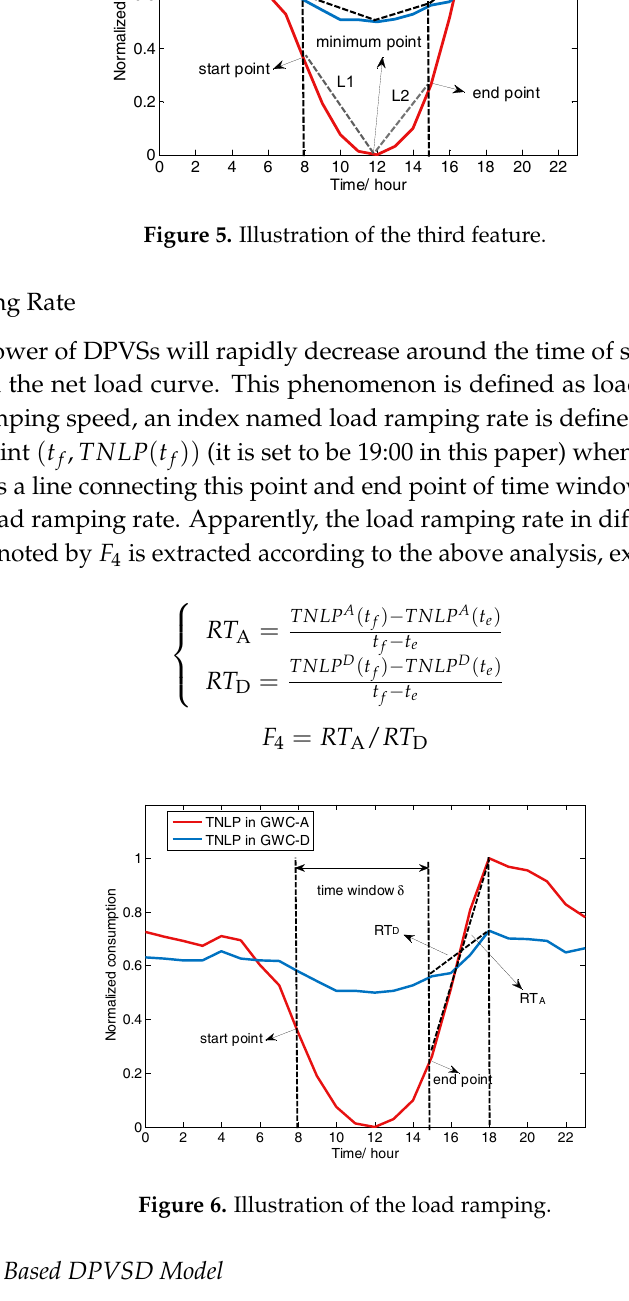
Figure 6. Illustration of the load ramping.